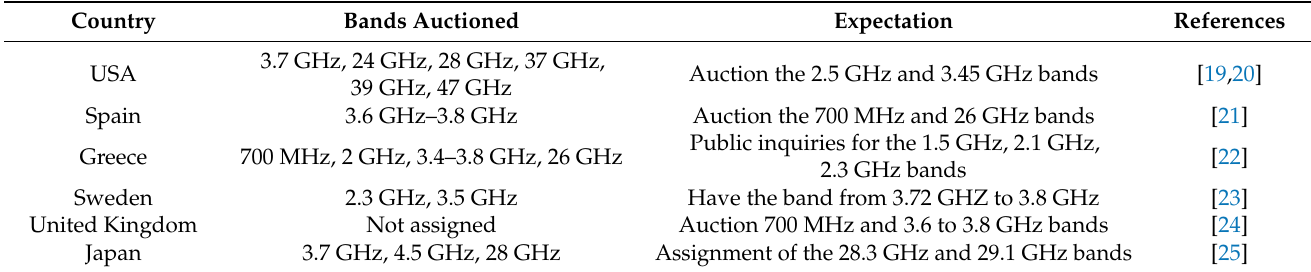
Table 2. Examples of auctioned bands for 5G service provision. Source: own elaboration. Country Bands Auctioned Expectation USA Spain Greece Sweden